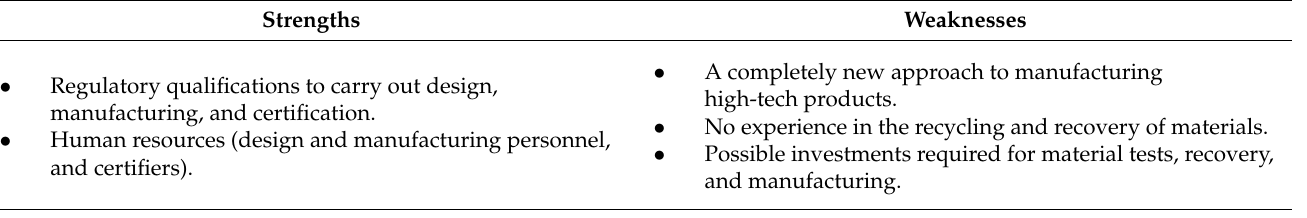
Table 3. SWOT analysis for an airline technical operation department to run closed-loop